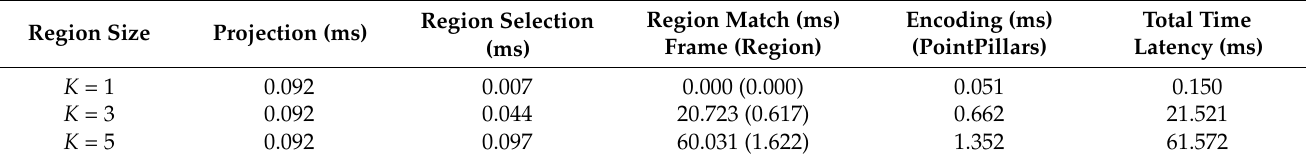
Table 4. Detailed time latency introduced by each component of the PMPF at different region sizes. Using PointPillars [10] as LiDAR